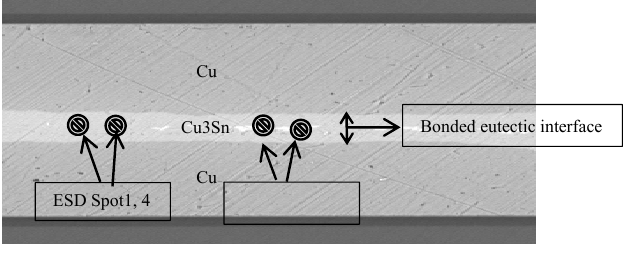
Figure 10. SEM photograph.